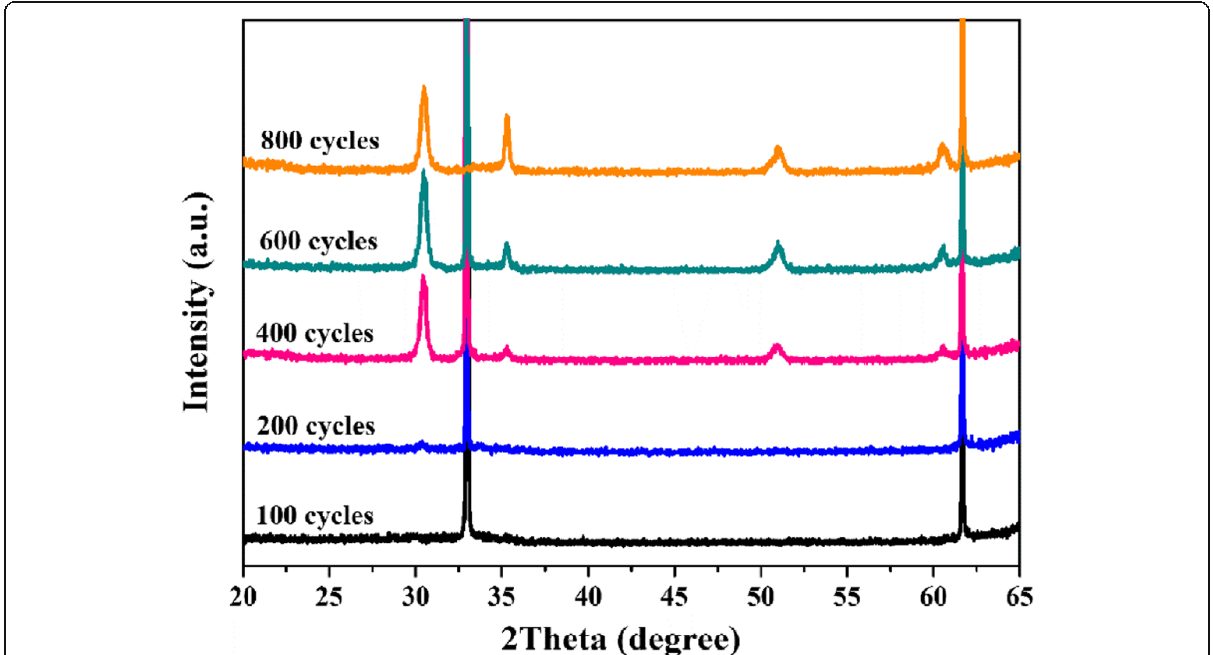
Fig. 11 The GAXRD patterns for the ZrO 2 films deposited at 250 °C with various ALD